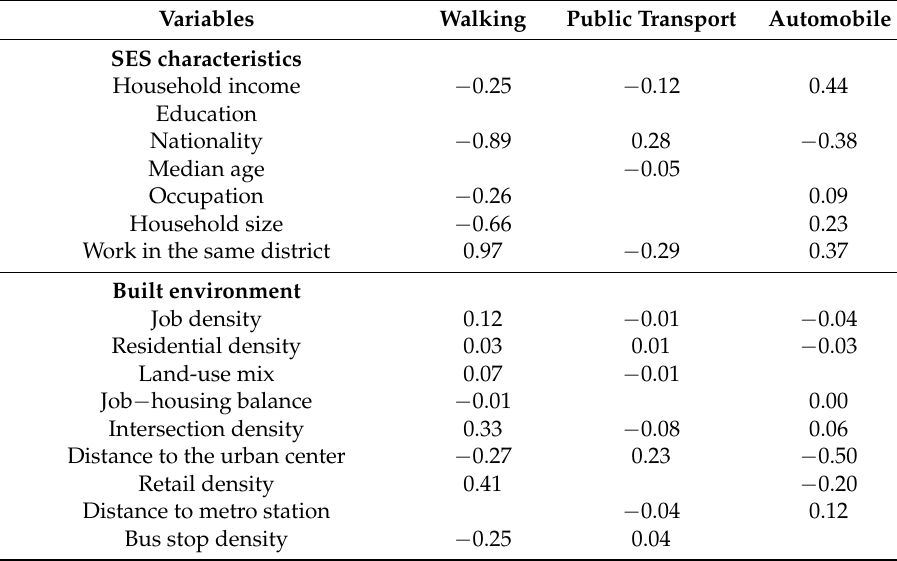
Table 4. Elasticity estmates for commuting mode choice a